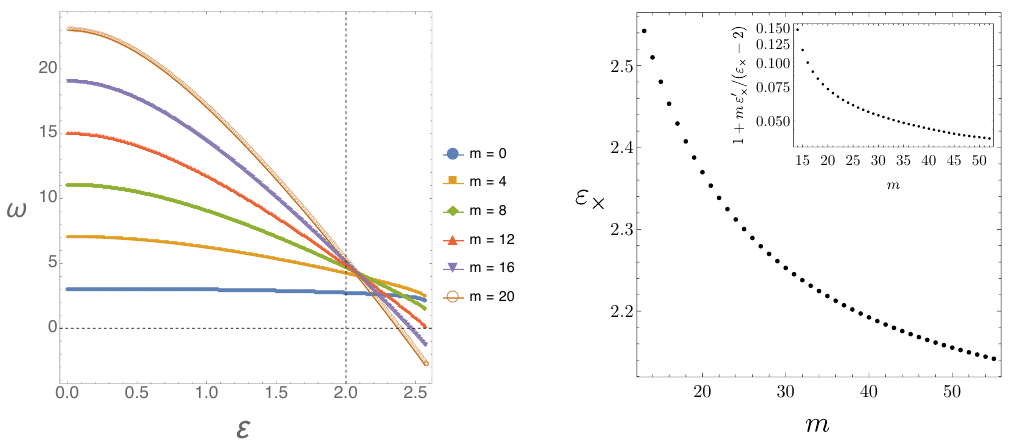
Figure 15 . Left : normal mode frequencies with ‘ = m vs the boundary rotation parameter " for the soliton metric. At " = 0 these reduce to the usual AdS 4 frequencies L ! = 3 + ‘ . Dashed gridlines show where " = 2 and Re ! = 0. Right : rotation amplitude " (cid:2) , where ! 2 becomes negative, against m . The inset shows the logarithmic derivative of " (cid:2) . We expect that in the limit m ! 1 , " (cid:2) ! 2.